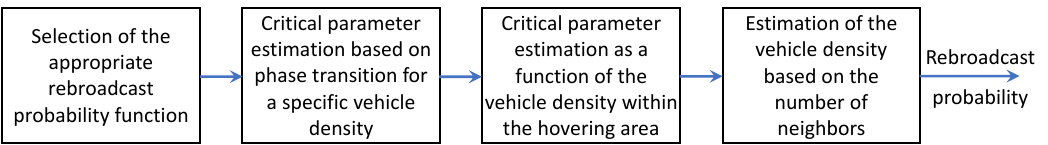
Figure 1. Schematic representation of the design